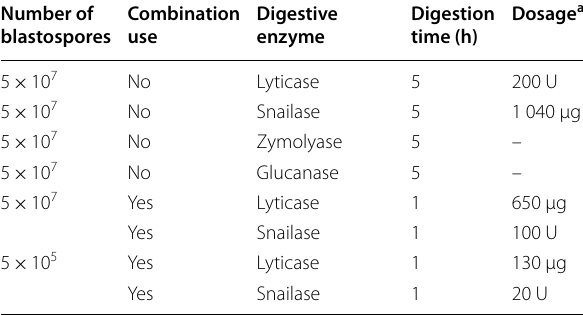
“-”means no obvious effect on SC5314 blastospores a enzyme dosage used in 1 mL system that could completely lyse specified number of blastospores Table 3 Impact of the lysis solution components on PCR amplification